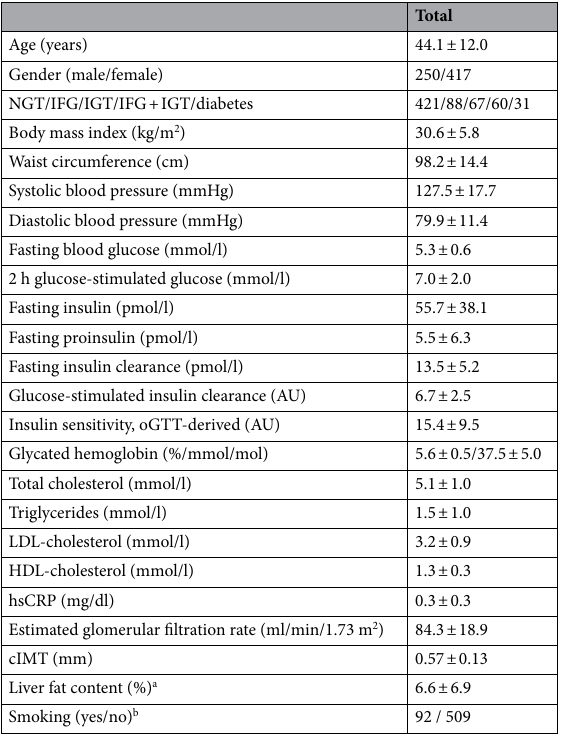
Table 1. Characteristics of the study population. Data shown as mean (± standard deviation). a Liver fat content was available for 484 individuals. b Smoking status was available for 651